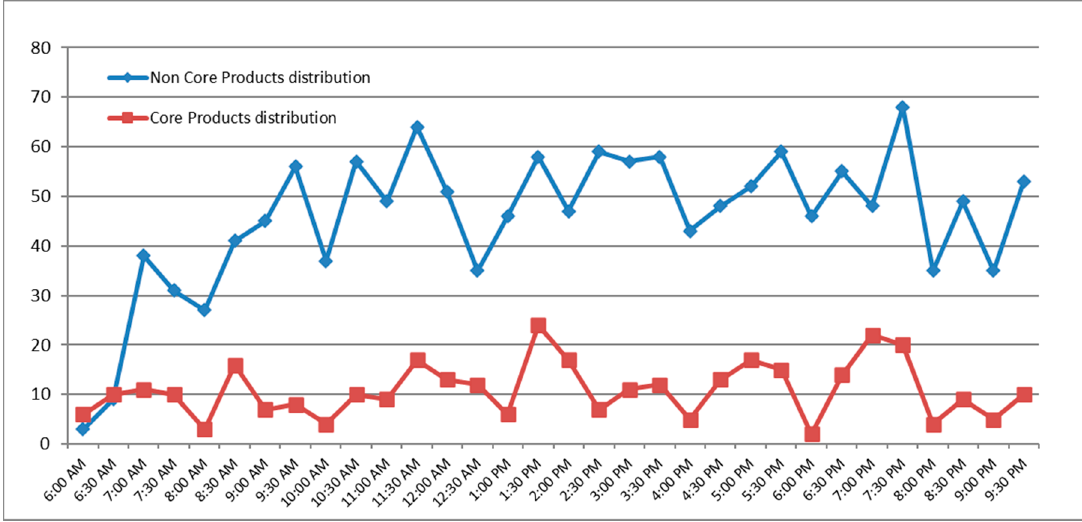
Figure 3. Distribution of core and non-core food among the time slots. Peak viewing time from 5:00 p.m. to 8:00 p.m.